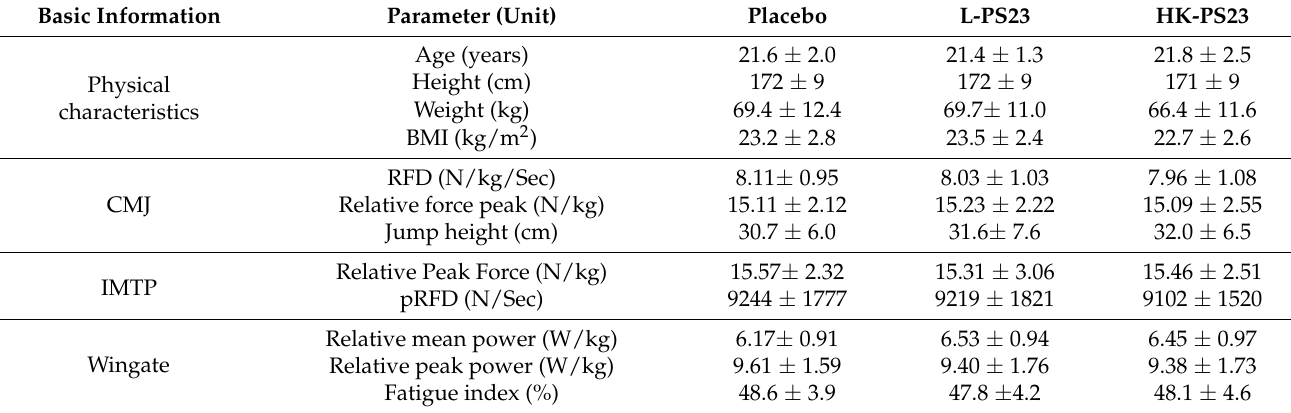
Table 1. Participant characteristics and physical fitness test at